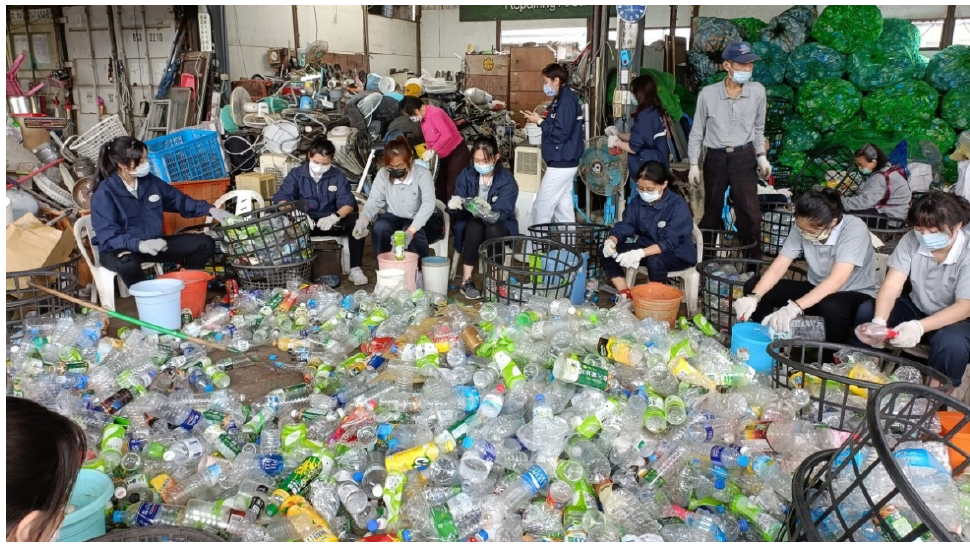
Figure 2. Undergraduates performing hands-on recyclables sorting within the recycling center.